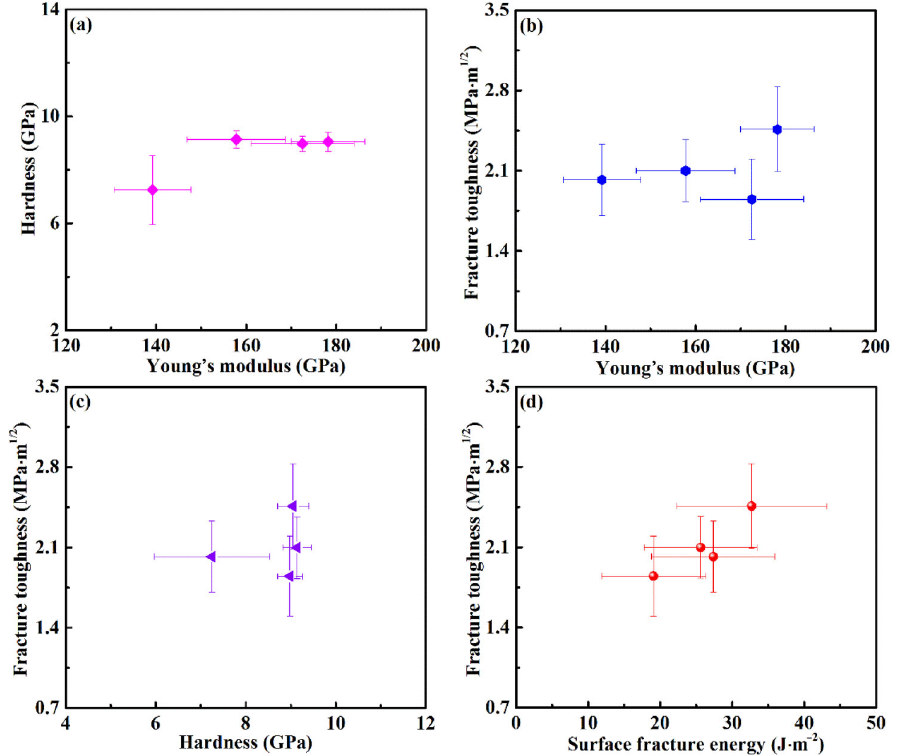
Fig. 4 Relationships among the mechanical properties of (La 1/5 Pr 1/5 Dy 1/5 Ho 1/5 Tm 1/5 )Ta 3 O 9 (5HEP-1), (Gd 1/5 Dy 1/5 Ho 1/5 Er 1/5 Tm 1/5 )Ta 3 O 9 (5HEP-2), (La 1/6 Sm 1/6 Eu 1/6 Dy 1/6 Ho 1/6 Tm 1/6 )Ta 3 O 9 (6HEP-3), and (Eu 1/6 Gd 1/6 Dy 1/6 Ho 1/6 Er 1/6 Tm 1/6 )Ta 3 O 9 (6HEP-4) ceramics: (a) hardness–Young’s modulus, (b) fracture toughness–Young’s modulus, (c) fracture toughness–hardness, and (d) fracture toughness–surface fracture